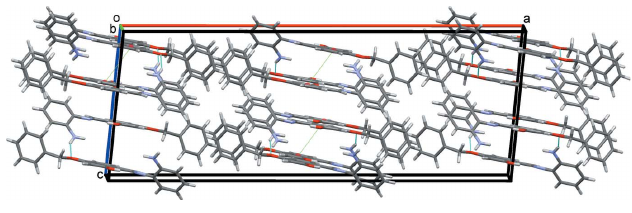
Figure 5 Overall packing for (I) viewed along the b- axis direction.